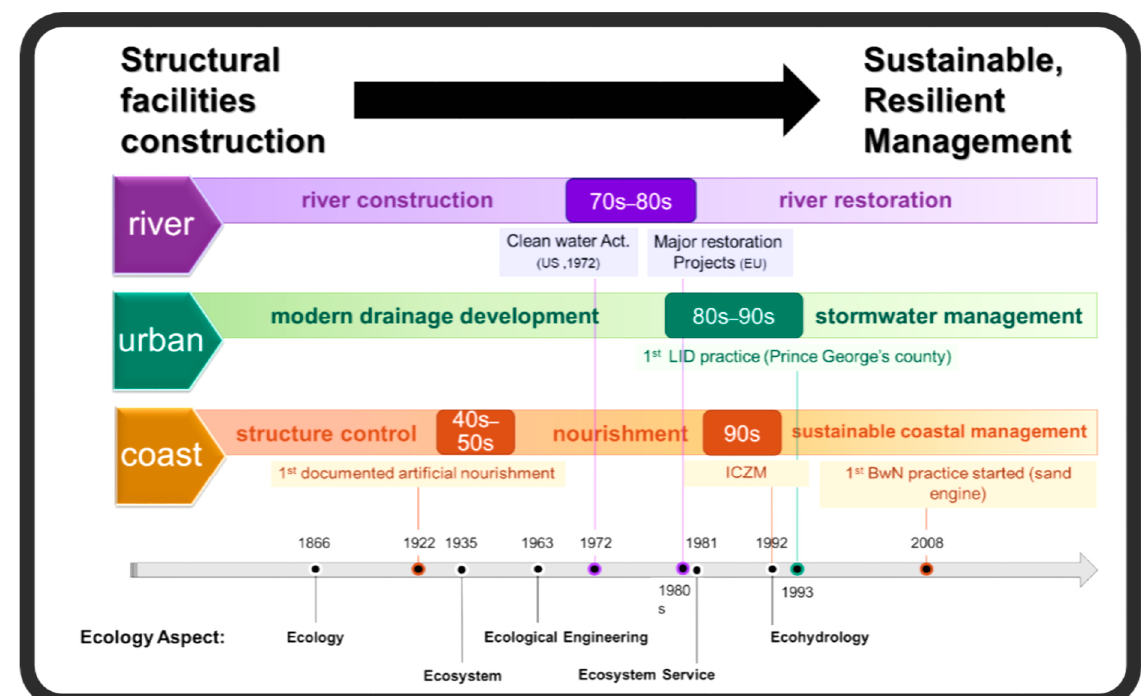
Figure 1. The evolutionary trends of flood strategies in the river, urban, and coastal area.